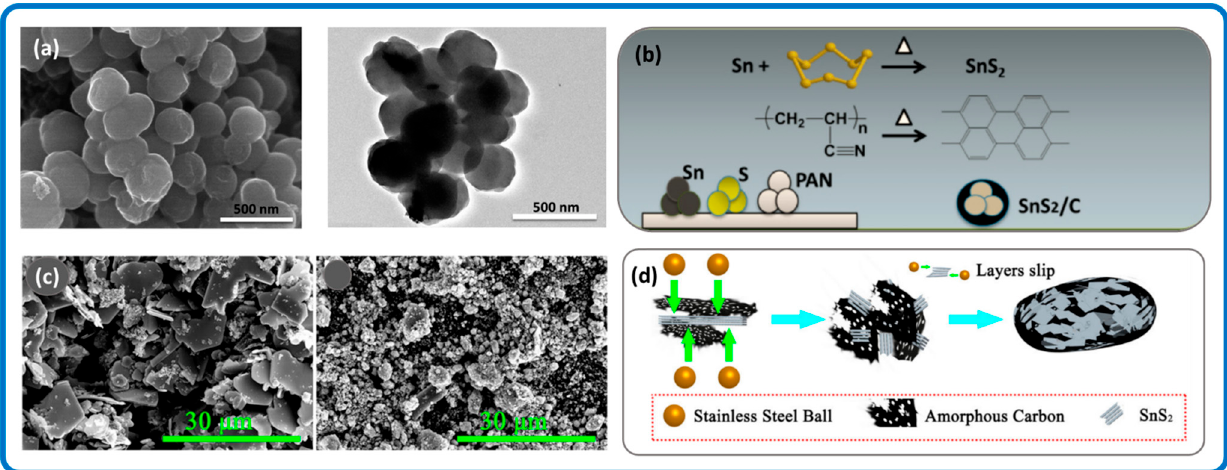
Figure 2. ( a ) SEM and TEM images, ( b ) Schematic illustration of solid-state synthesis route, of SnS 2 /carbon nanomaterials. Adapted with permission from [82]. Copyright 2015, American Chemical Society. ( c ) SEM images of un-milled and directly milled SnS 2 /Carbon. ( d ) Schematic illustration of ball milling of SnS 2 /carbon to decrease its crystallinity. Reprinted with permission from Springer Nature from [83]. Copyright 2016, Elsevier.